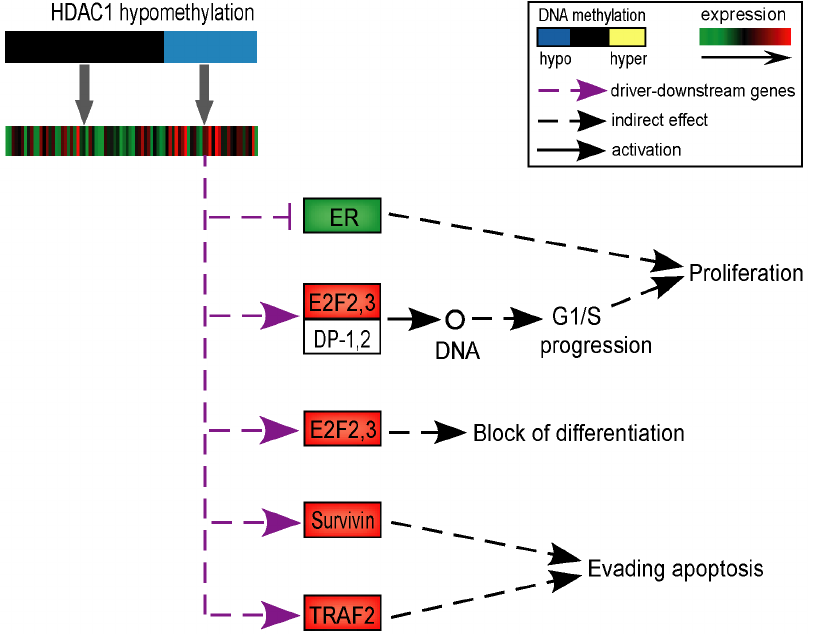
Figure 3. Downstream genes of hypomethylated HDAC1. The downstream genes with functional consequence in the KEGG ‘‘pathway in cancer’’ were selected. The purple arrows imply the relationship between driver gene and its downstream genes, and the dark arrows were collected from ‘‘pathway in cancer’’ of KEGG. The up-regulated genes are labeled with red color and the down-regulated genes are labeled with green color.